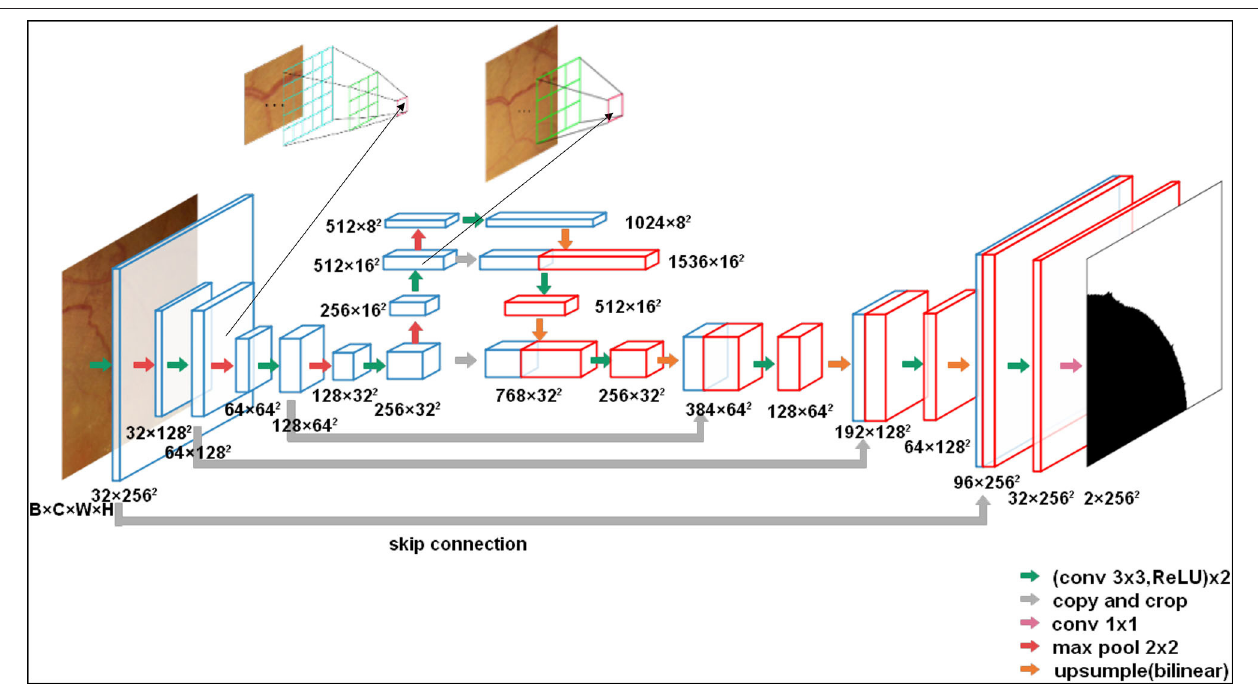
FIGURE 3 | The U-net architecture (3 × 256 × 256 input, for instance). Each green arrow corresponds to two 3 × 3 convolutions each followed by a rectified linear unit (ReLU). Red arrows correspond to a 2 × 2 max pooling operation with stride 2 for downsampling. The orange arrows indicate upsampling with bilinear interpolation. The gray arrows indicate the skip-connection in the U-Net. A 1 × 1 convolution is represented by a purple arrow at the end of the model.